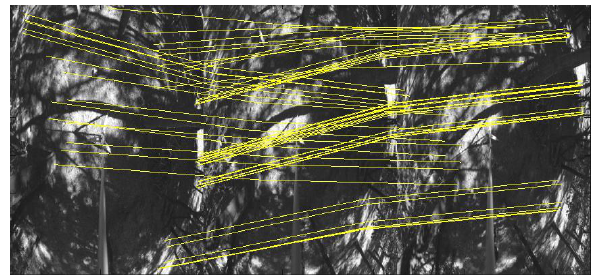
Figure 5. Matches using SIFT descriptors extracted among three multi-scale images.